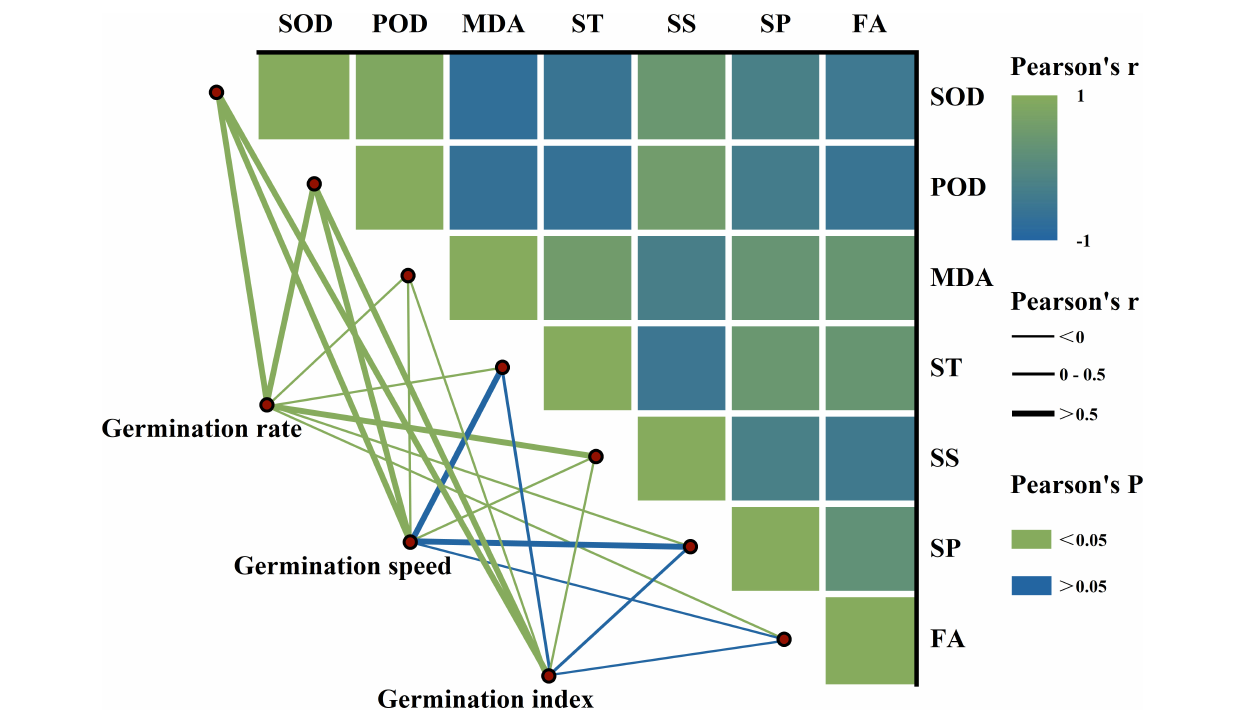
FIGURE 4 | The relationship between seed germination, antioxidant enzymes’ activity, and reserve mobilization of Suaeda corniculata . The color gradient denotes the Pearson’s correlation coefficient. The line width denotes the Pearson’s r value. The line color denotes the statistical significance level. SOD, superoxide dismutase; POD, peroxidase; MDA, malondialdehyde; ST, starch; SP, soluble protein; SS, soluble sugar; FA, fat.